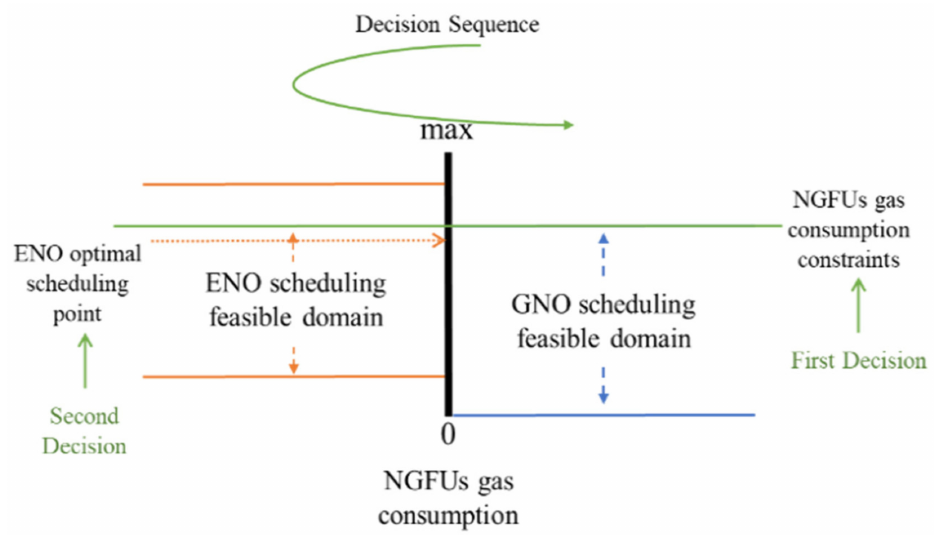
Figure 4. The diagram of the proposed CO framework.